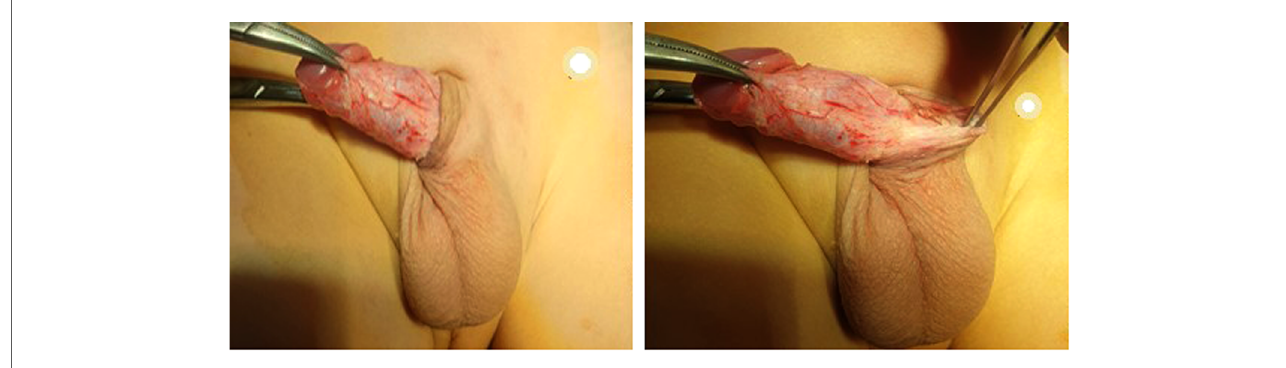
FIGURE 4 Degloving of the penis.